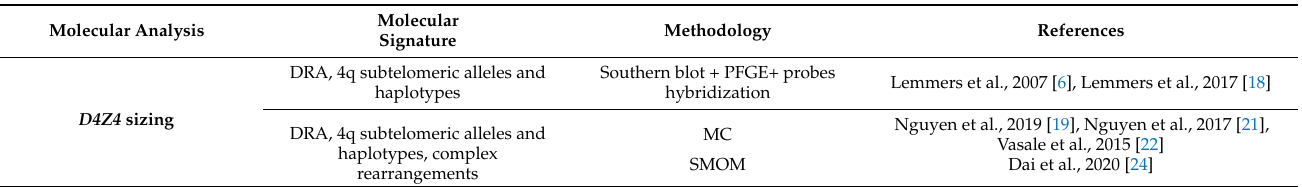
Table 1. Overview of the described investigated FSHD molecular signatures and corresponding analytical methods.